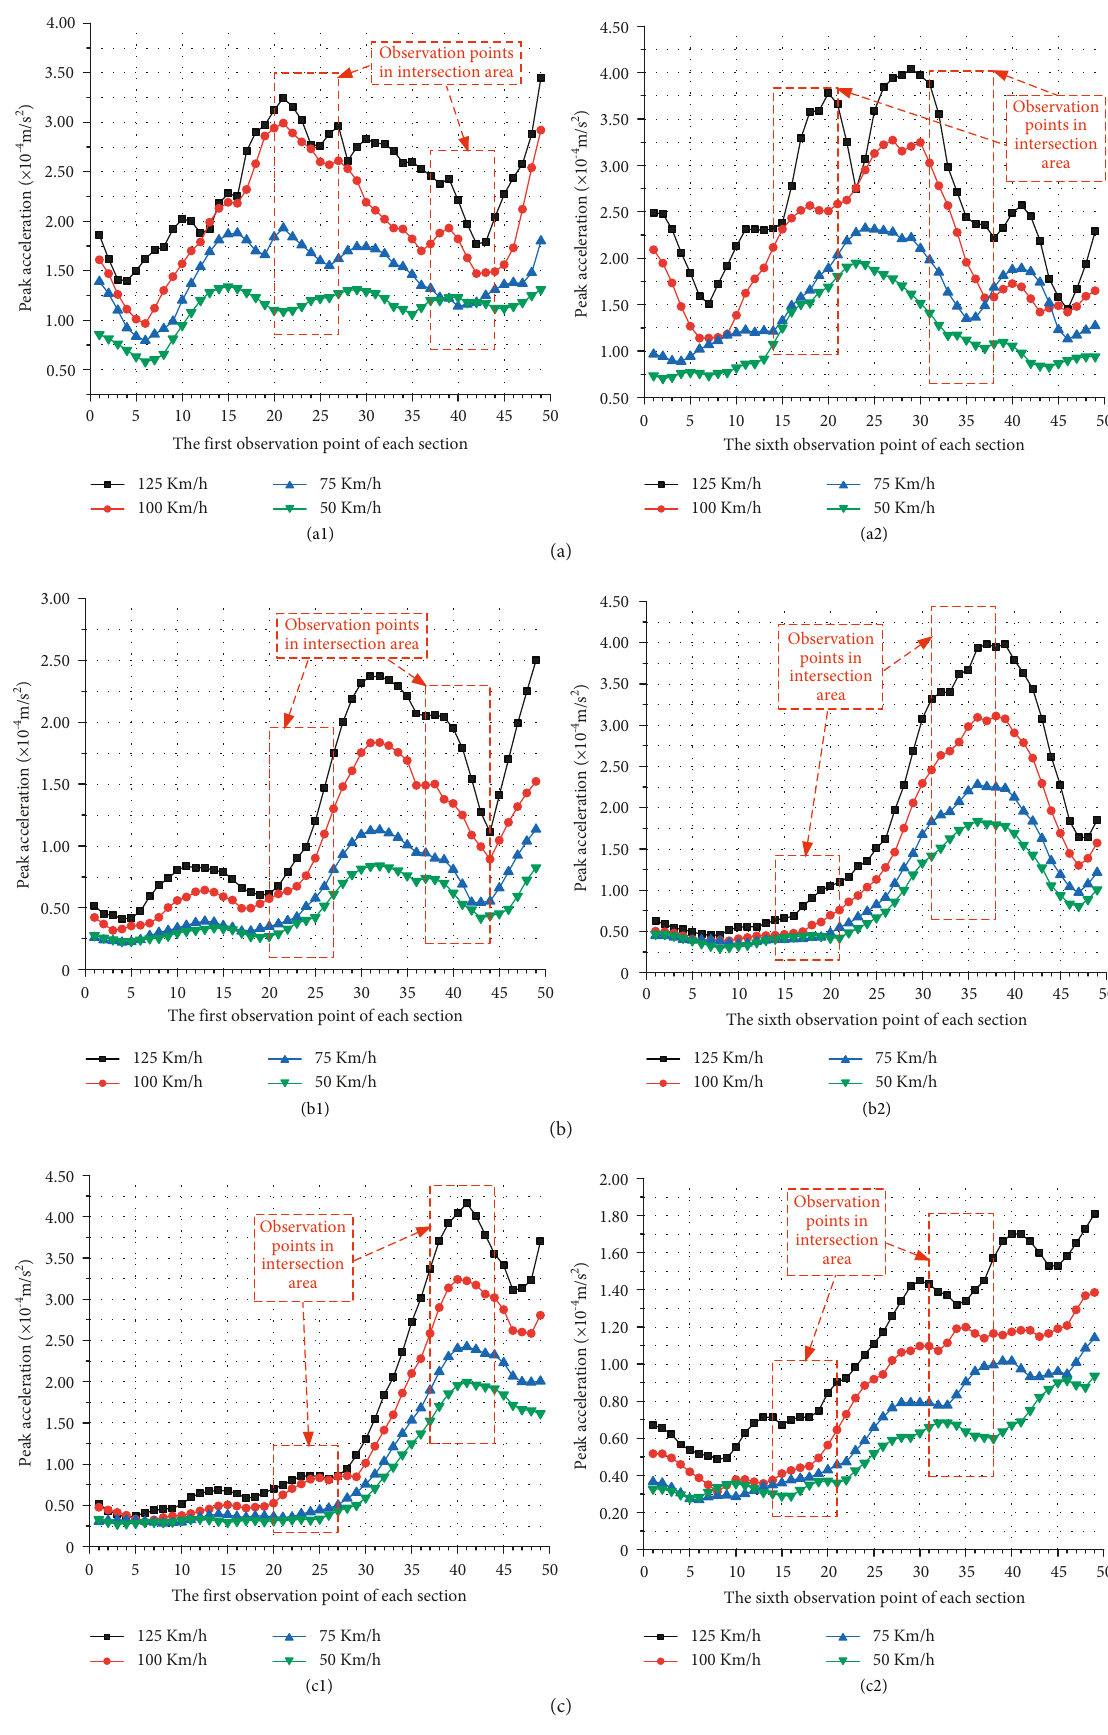
Figure 10: Peak acceleration of observation points on existing tunnel: (a) shield excavation reaches the 38th ring on the right; (b) shield excavation reaches the 52th ring on the right; and (c) shield excavation reaches the 67th ring on the